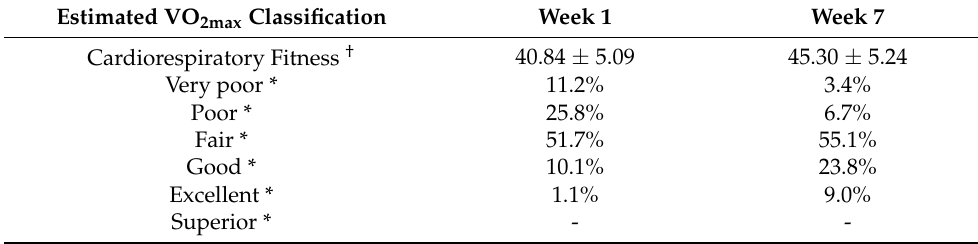
Table 5. Changes in Cardiorespiratory Fitness